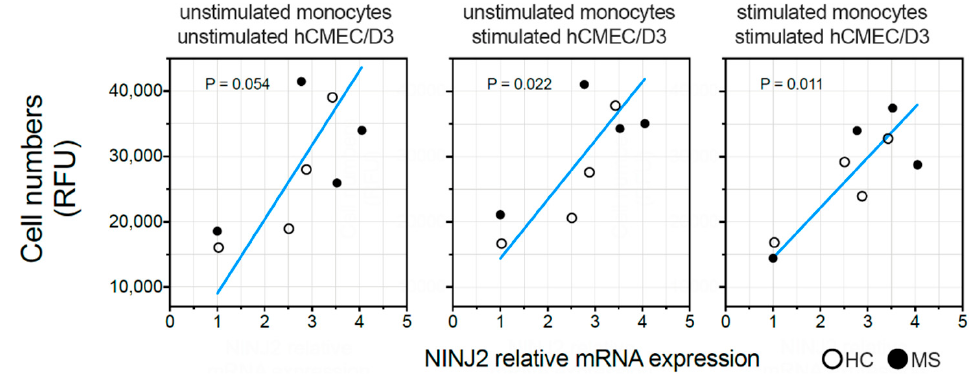
Figure 4. Relationship between NINJ2 basal expression and the migration rate. The basal expression of NINJ2 was correlated with the number of monocytes (expressed as Relative Fluorescence Units, RFU) migrating through the surrogate of BBB (hCMEC/D3 cell line) without stimulation (left panel, “unstimulated”), pre-stimulating hCMEC/D3 cells with LPS for 24 h (central panel, “hCMEC/D3 + LPS”) or pre-stimulating hCMEC/D3 cells and stimulating monocytes with LPS for 24 h (right panel, “hCMEC/D3 and monocytes + LPS”). Each dot represents one individual. Regression line is shown (blue line) according to Deming regression model. p values are reported for each panel.